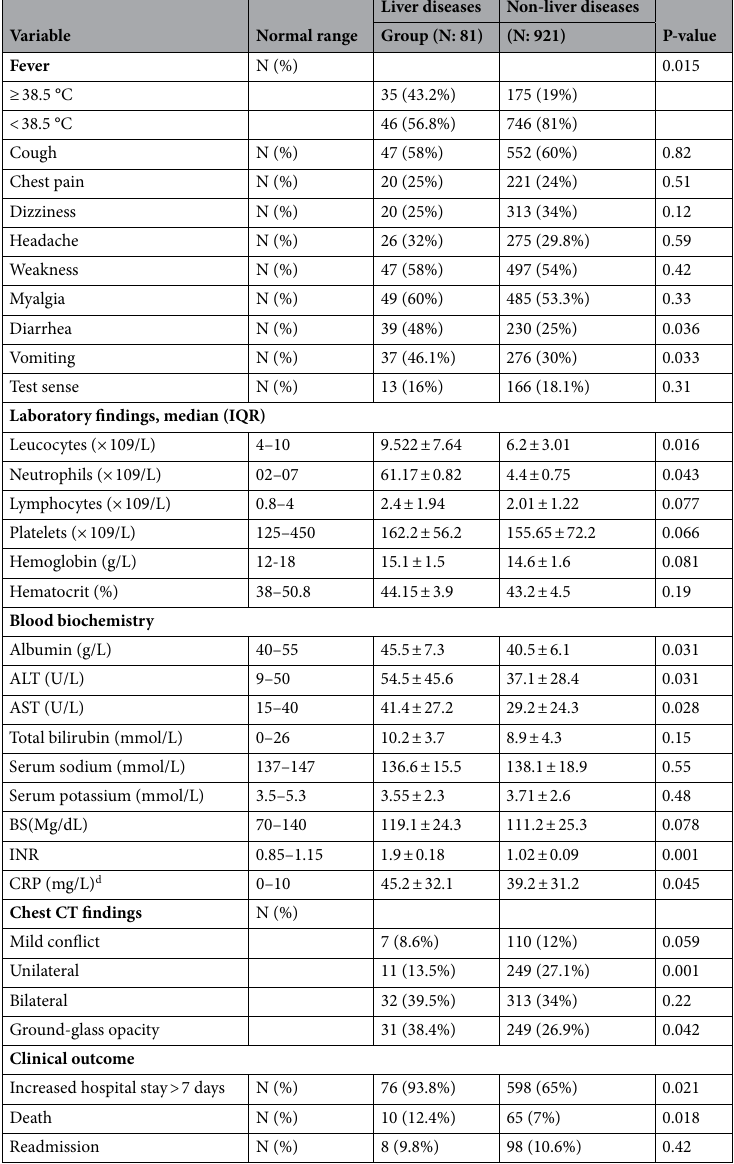
Table 2. Clinical characteristics and initial symptoms and laboratory indices among patients with and without liver diseases. PCR Polymerase chain reaction, ALT alanine aminotransferase, AST aspartate transaminase, BS blood sugar, INR international normalized ratio, CRP C-reactive protein.